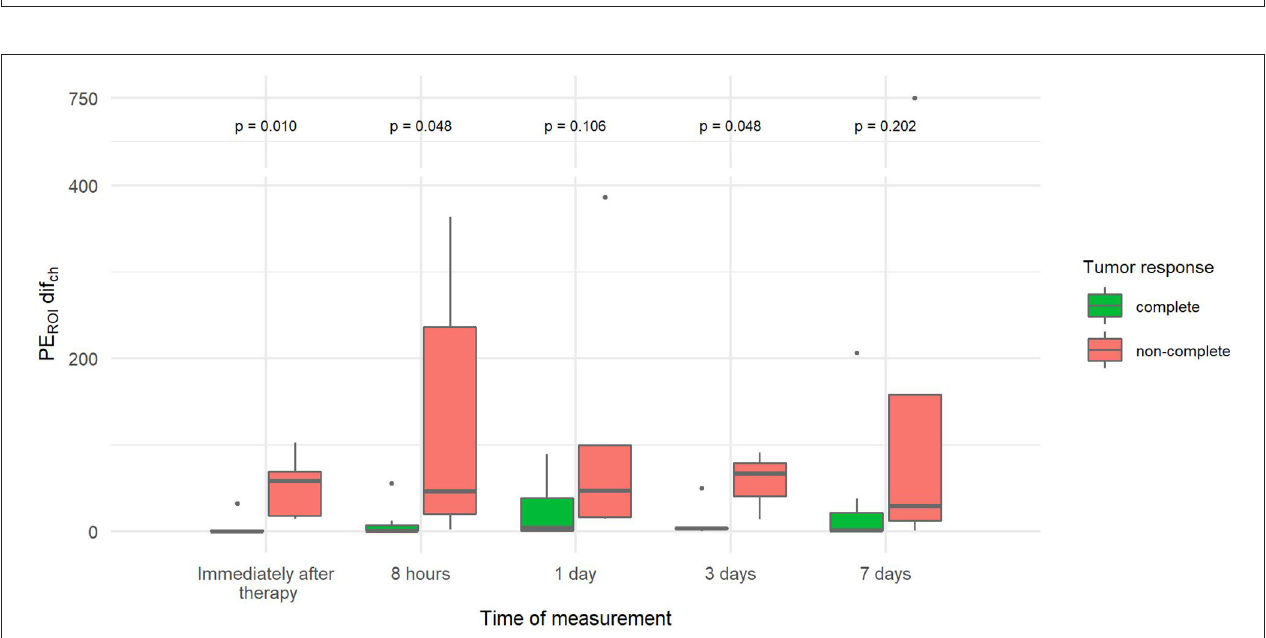
FIGURE 7 | Comparison of the percentage change in time to peak of tumor (TTP ch) at different time points canine tumors with complete and non-complete response to electrochemotherapy (ECT) with gene electrotransfer of plasmid DNA encoding interleukin IL-12 (GET pIL-12). Note the p -values presented at the top of the image. TTP ch is significantly lower for complete response tumors compared with non-complete response tumors 7 days after therapy.